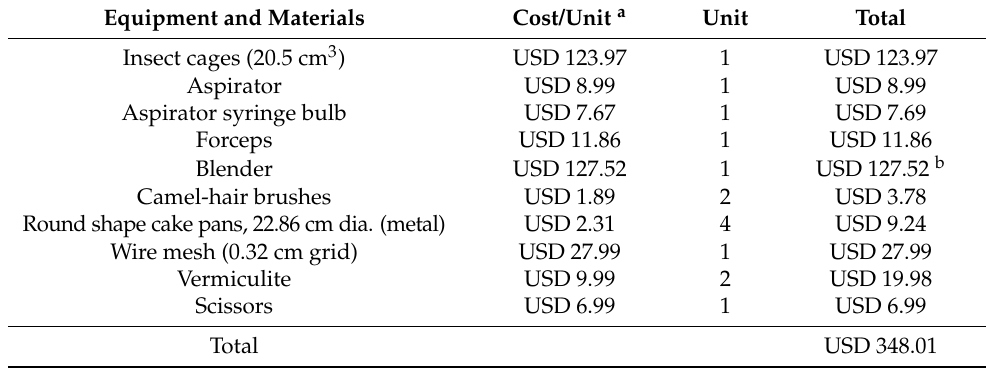
Table 3. The initial investment cost for producing C. marginiventris and S. frugiperda to adults.